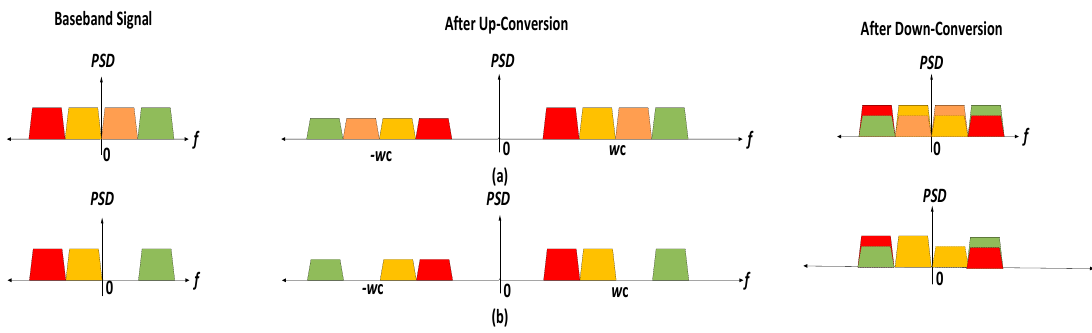
Figure 6. Mirror frequency Imaging (MFI) due to I / Q imbalance. ( a ) MFI for symmetric 1111 signal for which the power in the image band cannot be seen using PSD; ( b ) MFI for asymmetric signals and the power in the image band is visible.